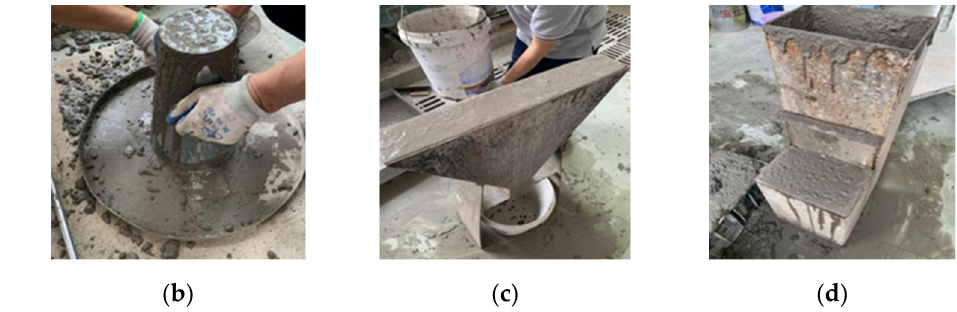
Figure 2. ( a ) Slump extension test; ( b ) extension time T500 test; ( c ) V funnel test; ( d ) L flow meter test.